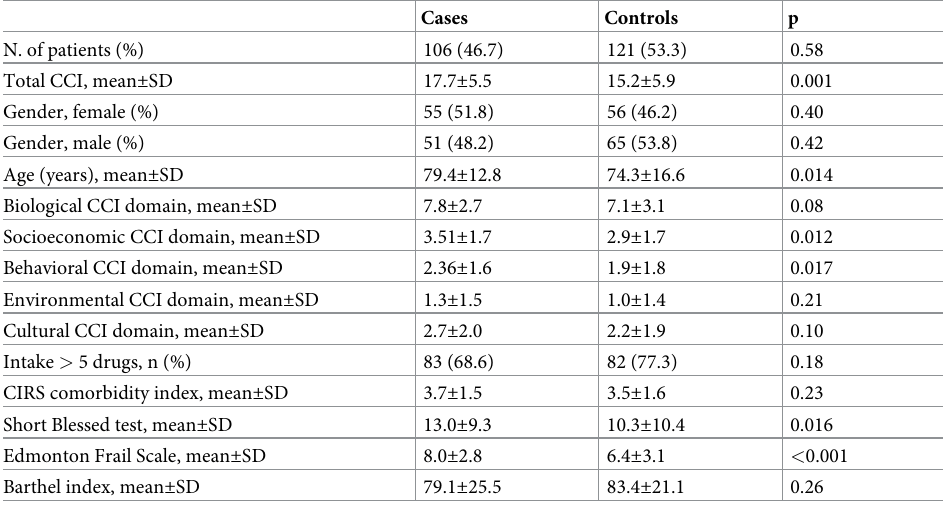
Table 1. Sociodemographic and baseline characteristics of 227 patients consecutively admitted to an internal medicine ward during a holiday period (cases; 15 December—15 January) compared to a contiguous period (con- trols; 16 January—16 February) between